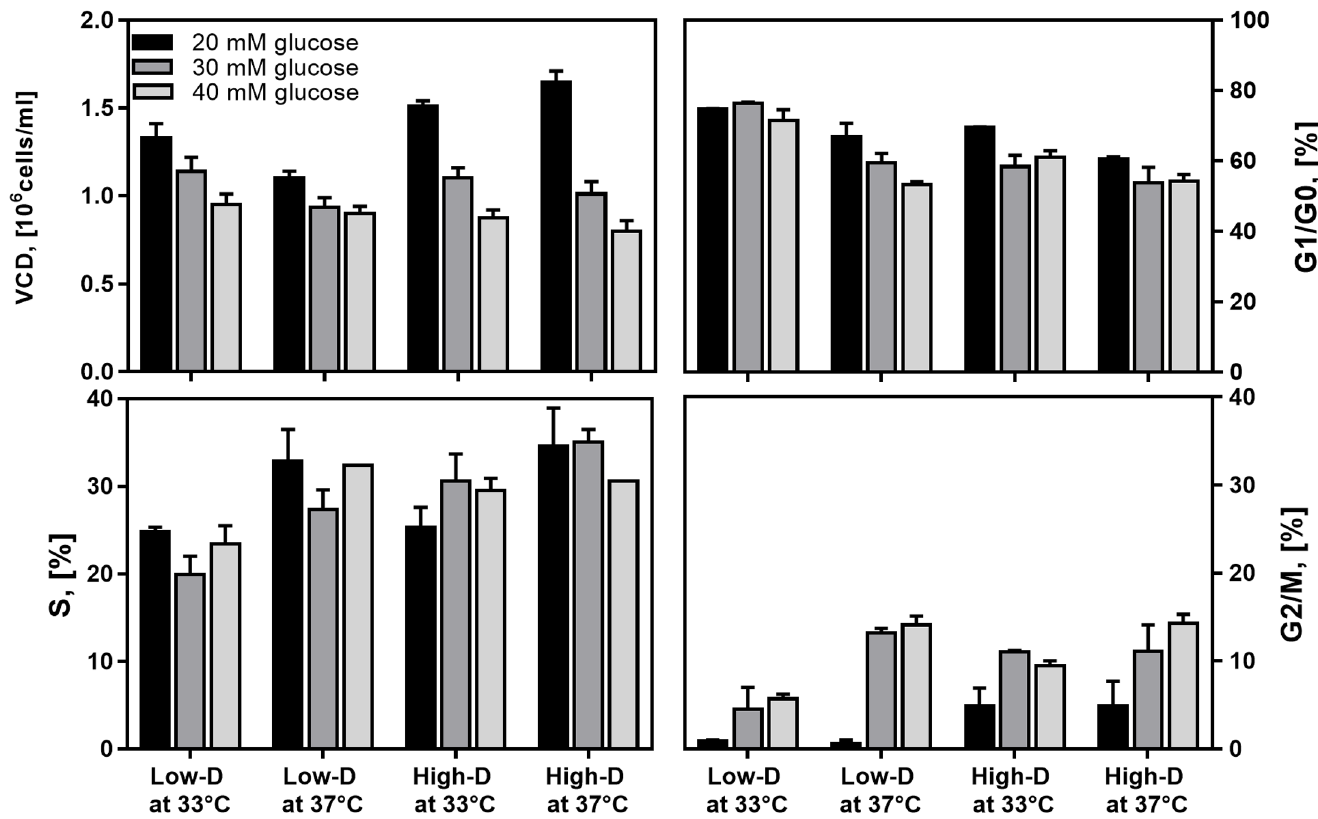
Fig 1. Impact of dilution rate, culture temperature and feed glucose concentration on viable cell concentration and cycle distribution in CHO cell chemostat cultures at steady state. ( Black ) 20 mM glucose; ( Dark grey ) 30 mM glucose; ( Light grey ) 40 mM glucose.